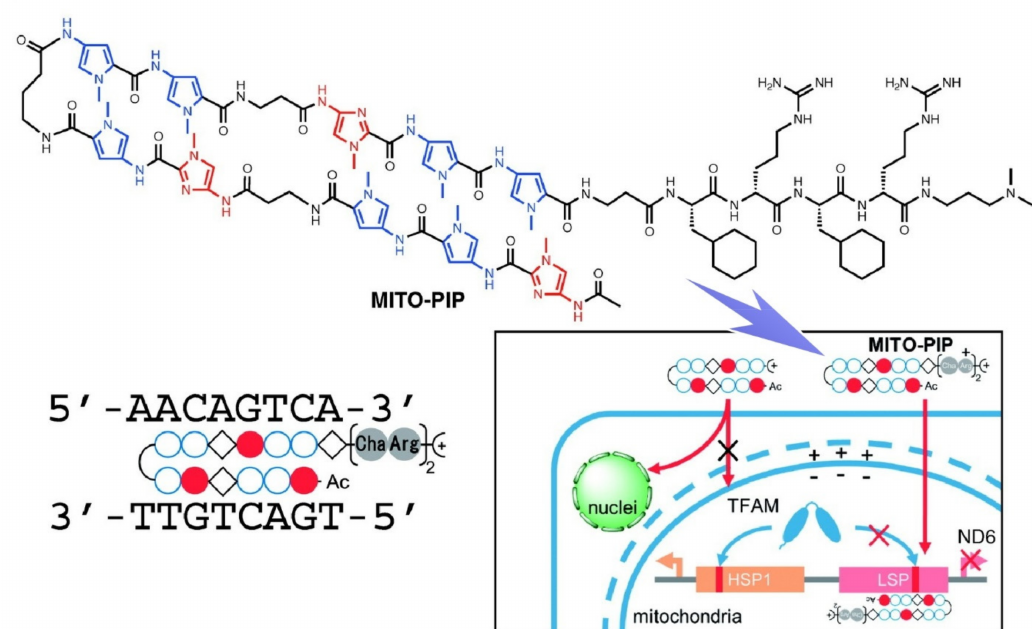
Figure 13. Peptide sequence with cyclohexylalanine and arginine attached to the polyamide for regulation of the expression of mitochondrial DNA within mitochondria. Reprinted with permission from Reference [148]. Copyright 2020 Chemical Society of